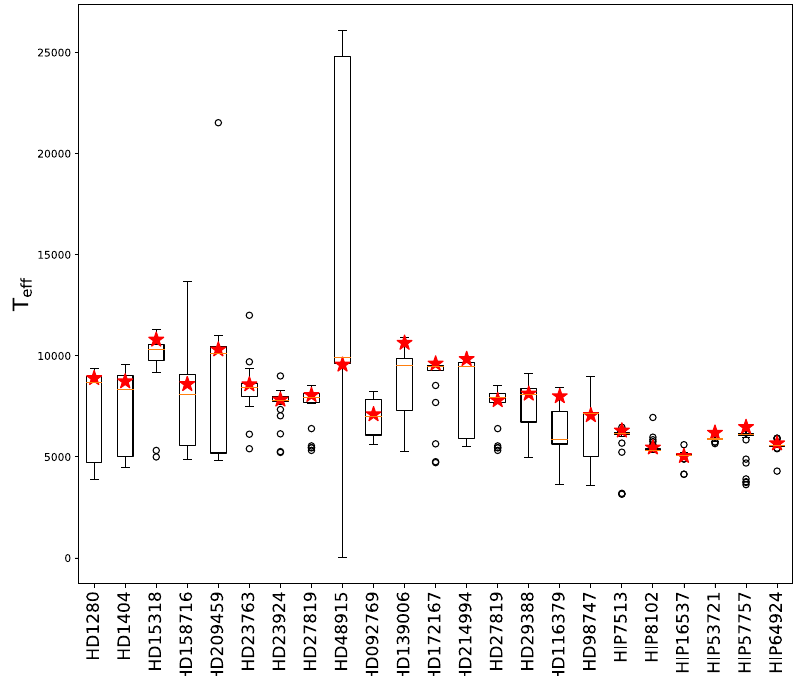
Figure 4: Comparison between our predicted e ff ective temperatures ( stars ) , and the values we obtained from available Vizier catalogs. The cataloged values are represented as classical boxplots. The objects we studied are listed along the horizontal axis. The horizontal bar inside each box indicates the median ( Q 2 value ) , while each box extends from the fi rst quartile, Q 1 , to the third quartile Q 3 . Extreme values, still within 1.5 times the interquartile range away from either Q 1 or Q 3 , are connected to the box with dashed lines. Outliers are denoted by an “ o ”